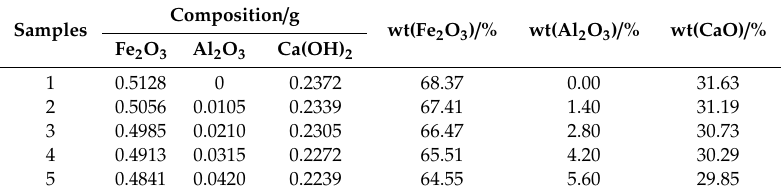
Table 1. Sample compositions of solid-state reaction experiments by addition of Ca(OH) 2 at a 1:1 molar ratio of n (Fe 2 O 3 ) to n